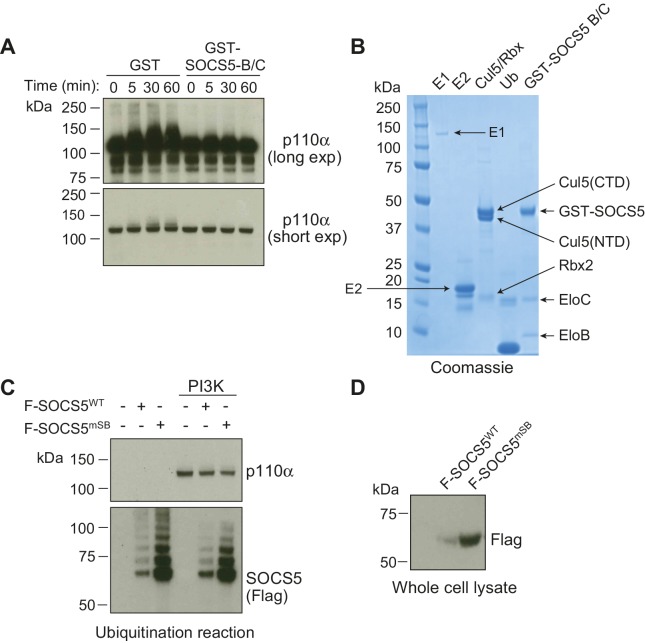
SOCS5 does not ubiquitinate PI3K p110α in vitro.In vitro ubiquitination assays. (A) Recombinant PI3K p110α was incubated with GST alone or GST-SOCS5-SH2-SOCS box in complex with Elongin B/C (GST-SOCS5-B/C), together with Cullin 5, Rbx2, ubiquitin and E2 enzyme at 37°C. Reactions were initiated by the addition of E1 enzyme and samples collected at the indicated times, prior to immunoblot analysis with anti-PI3K antibodies. The lack of higher molecular weight species in the presence of SOCS5 indicates that no SOCS5-mediated ubiquitination of PI3K p110α was observed. Exp: exposure. (B) Coomassie stained gel showing all components of the ubiquitination reaction. CTD: C-terminal domain, NTD: N-terminal domain, EloB: Elongin B, EloC: Elongin C. (C) Flag-tagged, full-length SOCS5 (F-SOCS5) was enriched from 293T cells and incubated at 37°C for 1 h with the components of the E3 ligase complex in the presence or absence of recombinant PI3K p110α. Immunoblot analysis of PI3K p110α indicates no SOCS5-mediated ubiquitination of PI3K (WT: wild-type; mSB: SOCS5-L484P, C488F, a non-functional SOCS box). (D) Immunoblot analysis with anti-Flag antibodies showing expression of SOCS5 prior to enrichment.